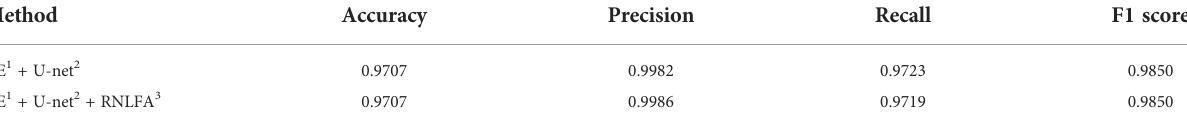
TABLE 1 Performances of the leaf segmentation for g =1.5.